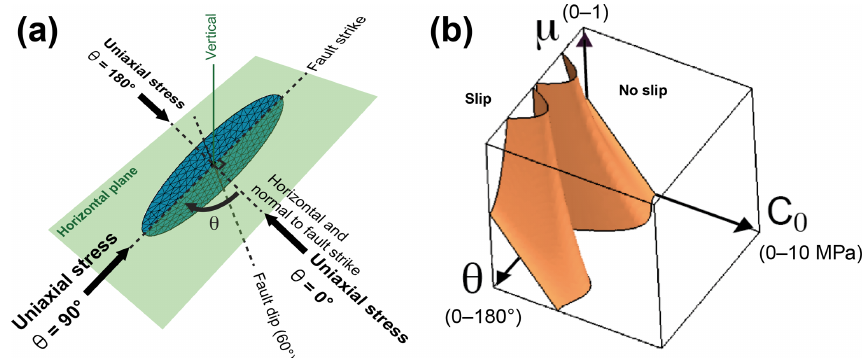
Figure 1. Fault slip envelope of a simple-planar elliptical fault of 60 ◦ dip. (a) Scheme of the relationship between fault strike, dip, and remote uniaxial stress orientation. (b) Fault slip envelope expressed as static friction ( µ ), cohesion ( C 0 ), and uniaxial stress angle ( θ ). The stable (no slip) and unstable (slip) graphical domains are shown on either side of the fault slip